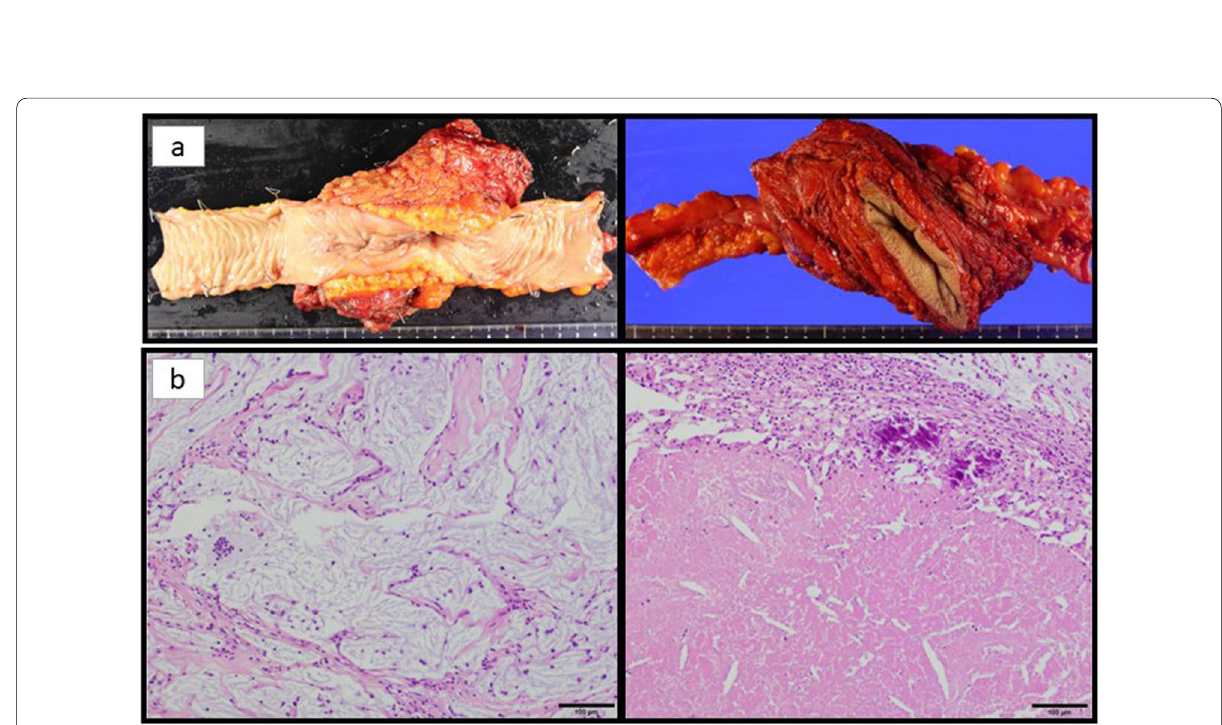
Fig. 3 a Resected specimen. b Pathological findings. Mucus components and fibrous tissue were found in the area where the tumor was thought to have existed, but no malignant cells were